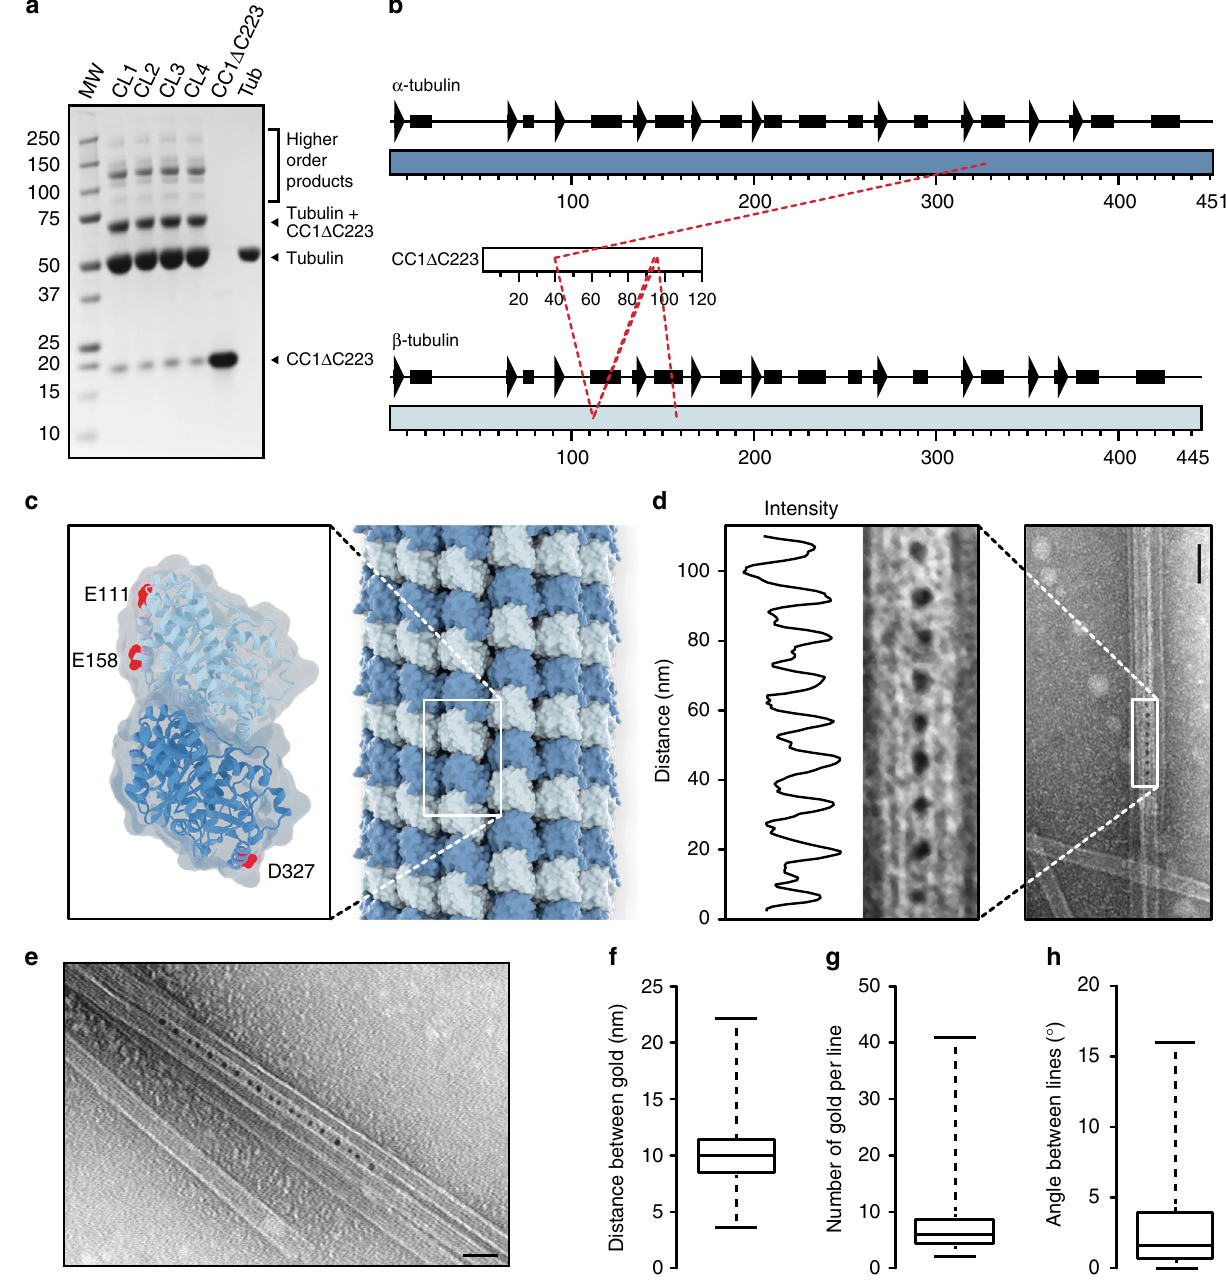
Fig. 1 The N-terminus of CC1 binds sites on both α - and β -Tubulin and cross-links microtubules. a SDS-Page of EDC-induced cross-linking of 6xHis-CC1 Δ C223 (16kDa) and tubulin dimers (2×55kDa). Arrowheads depict position of relevant protein bands. MW molecular weight marker, CL1-4 cross-linking reaction 1 – 4. Higher order cross-linking products represent cross-links between e.g. tubulin + 2 × CC1 Δ C223 (87kDa), tubulin dimers (110kDa), tubulin dimers + CC1 Δ C223 (126kDa), tubulin dimers + 2 × CC1 Δ C223 (142kDa). b Schematic views of the secondary structures of α - and β -tubulin, and the CC1 Δ C223 sequence. Dashed lines depict detected cross-linking positions of CC1 Δ C223 and α - or β -tubulin. c Projection of detected cross-links onto an α / β -tubulin dimer (PDB code 1tub). Dark blue = α -tubulin; Light blue = β -tubulin; Sites for cross-linked amino acids are marked in red. d Representative TEM image of CC1 Δ C223 distribution along negatively stained, taxol-stabilized microtubules polymerized in the presence of 6xHis-CC1 Δ C223. CC1 Δ C223 protein is visualized by a 5nm gold-conjugated Ni-NTA tag that recognizes 6xHis-tagged proteins. A transect was taken along rows of gold particles, and dips in the light intensity along the transect correspond to gold particle centers. Note the even distribution of the electron-dense gold particles in between neighboring microtubules. Scale bar = 50nm. e CC1 Δ C223 distribution along negatively stained, taxol-stabilized microtubules polymerized in the presence of 6xHis-CC1 Δ C223. CC1 Δ C223 can form a zipper-like pattern that links microtubules. Scale bar = 100nm. f Quanti fi cation of the distance between individual gold particles as shown in d and e (box plot: Center lines show the medians; box limits indicate the 25th and 75th percentiles; whiskers extend to the minimum and maximum). g , h Quanti fi cation of number of gold labels per row ( g ) and the angle between adjacent gold-labeled rows ( h ) from images as those in d and e (box plots: Center lines show the medians; box limits indicate the 25th and 75th percentiles; whiskers extend to the minimum and